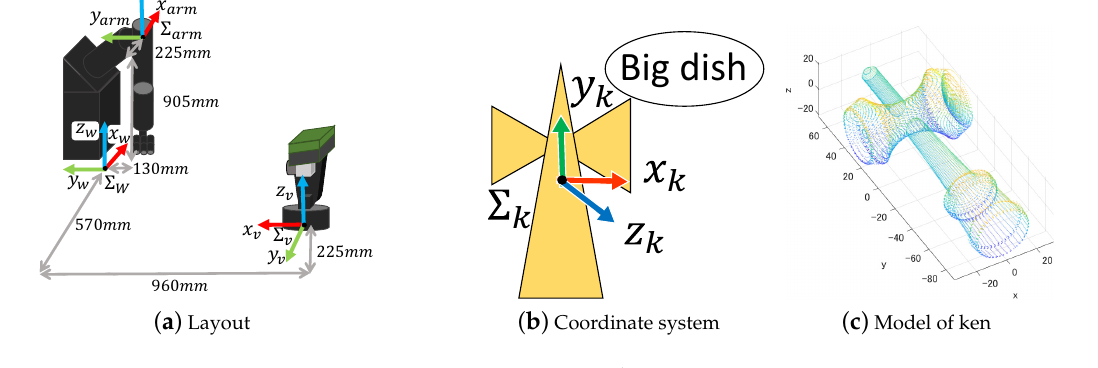
Figure 12. Experimental setup.